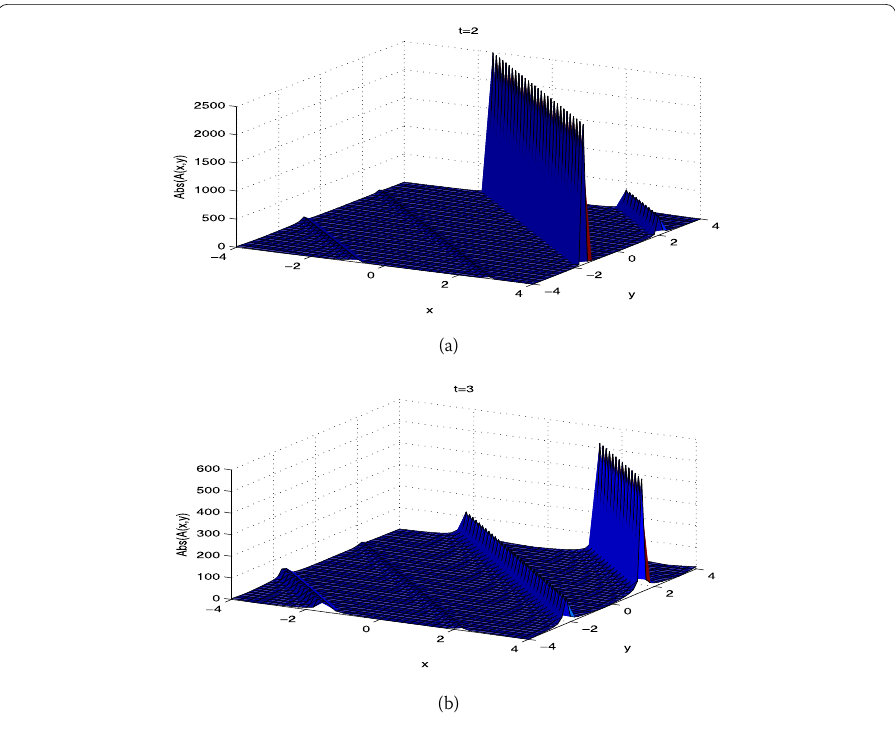
Figure 3 ( a ) The exact solution represented by Eq. (78), t = 2, α = 0.75, β = 1, γ = 1. ( b ) The exact solution represented by Eq. (78), t = 3, α = 0.75, β = 1, γ = 1